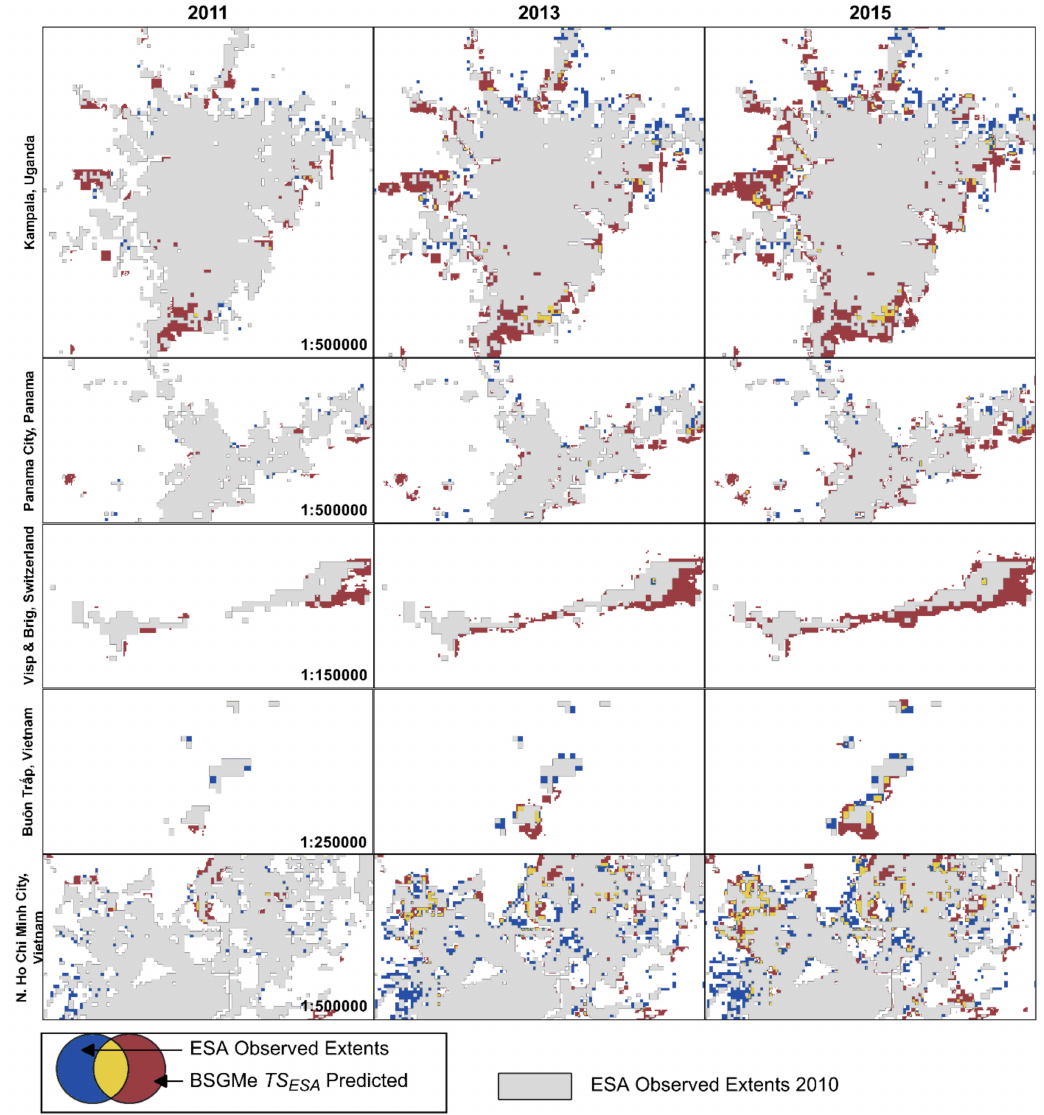
Figure 6. Map of select areas from the study countries and the projection period showing the predicted extents derived from the BSGMe (red) as well as the withheld ESA observed extents (blue). Areas where the BSGMe-derived extents and the ESA RS-derived extents agreed are shown in